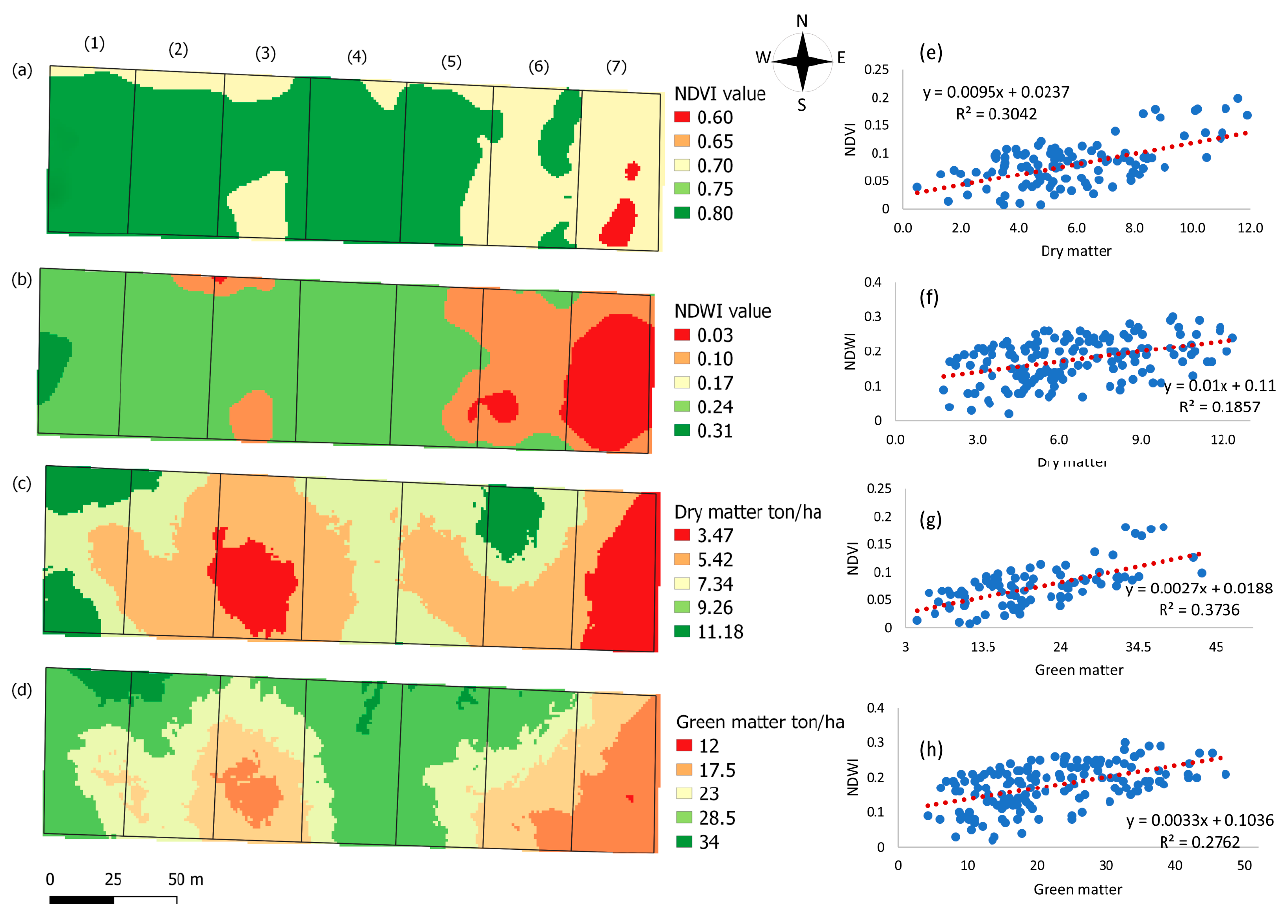
Figure 3. NDVI map ( a ); NDWI map ( b ); DM Kriging map (dry matter, ton/ha − 1 ) ( c ); GM Kriging map (green matter, ton/ha − 1 ) ( d ). Regression graphs between DM (dry matter) and NDVI ( e ); DM (dry matter) and NDWI ( f ); GM (green matter) and NDVI ( g ); and GM (green matter) and NDWI ( h ). The vegetative index, DM, and GM map combinations indicated considerable spatial variations in the NDVI values. The sampling sites in the vegetation area with the lowest forage mass, represented by red colors (Figure 3a–d), were the same paddocks with the lowest soil pH values (4.55 and 4.4) at all soil depths (Figure 3a–c); therefore, a more acidic soil was seen to be less favorable for forage